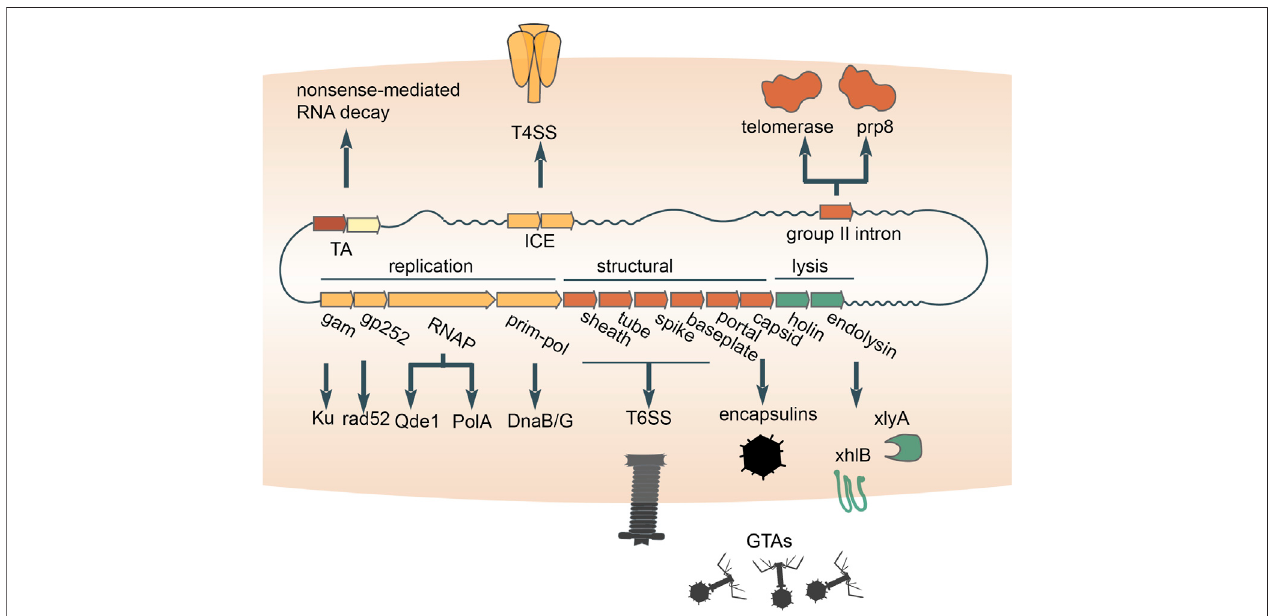
FIGURE 4 | Multiple contributions of distinct mobile genetic elements to intercellular transfer pathways and eukaryogenesis. Exaptations of toxin-antitoxins (TAs), integrative and conjugative elements (ICE), bacterial retrotransposons and double-stranded DNA bacteriophages are diagrammed. An RNA-cleaving toxin apparently wasincorporatedintotheeukaryoticnonsense-mediatedRNAdecaysystem.TheconjugationapparatusofICEwasexaptedforthetransferofproteins(type4secretion systems). Recruitment ofthe reverse transcriptase from bacterial retrotransposons yielded thekey component ofthe eukaryotic spliceosome, Prp8 (accompanied by inactivation of the reverse transcriptase), as well as telomerases which retain the activity. The structural module of double-stranded DNA bacteriophages was repurposed for the delivery of proteins (type 6 secretion systems) or host DNA (GTAs) between cells. The replication and lysis modules donated multiple genes that play diverse roles in both prokaryotes and